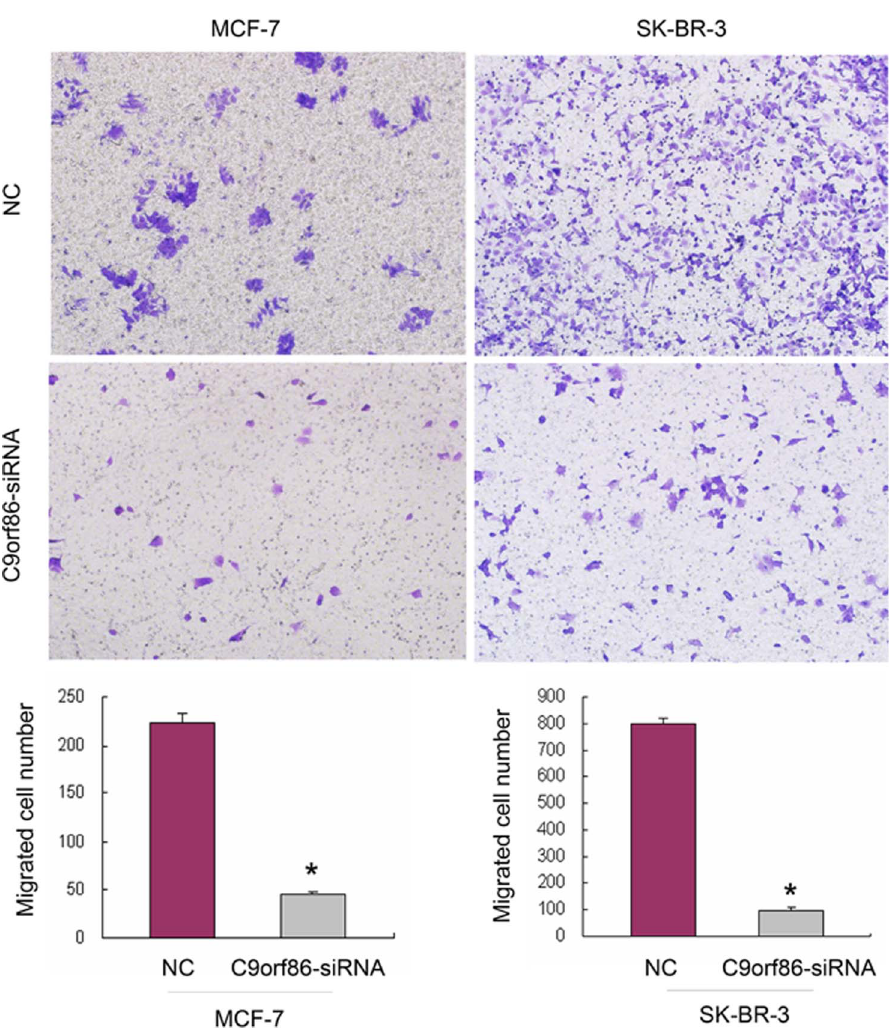
Figure 6. C9orf86 expression and survival in breast cancer patients. (A) and (B) Representative staining of C9orf86 in the cytoplasm of breast cancer cells, by IHC staining at 40 6 and 200 6 magnifications. (C) Kaplan-Meier estimates of overall survival curves for different C9orf86 expression levels in breast cancer patients, stratified by clinical stage.